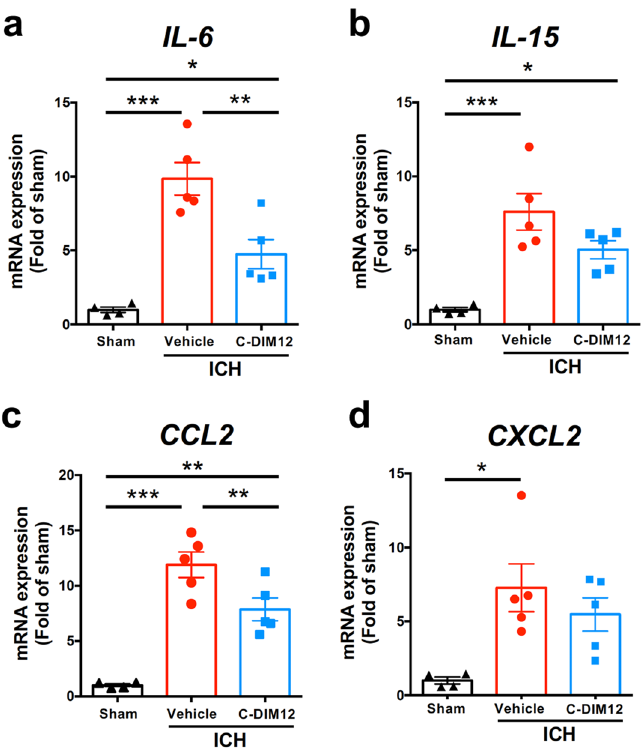
Figure 3. Effect of C-DIM12 on gene expression of pro-inflammatory cytokines and chemokines after ICH. C-DIM12 (50 mg/kg) or vehicle was orally administered at 3 h after ICH induction. Expression levels of IL-6 ( a ), IL-15 ( b ), CCL2 ( c ) and CXCL2 ( d ) mRNAs were quantified at 6 h after ICH. Number of mice examined was 4 in sham group, 5 in ICH + vehicle group, and 5 in ICH + C-DIM12 group, respectively. * P < 0.05, ** P < 0.01, *** P < 0.001 (ANOVA results: for a , F 2,11 = 22.26, P < 0.001; for b , F 2,11 = 14.07, P < 0.001; for c , F 2,11 = 30.44, P < 0.001; for d , F 2,11 = 6.360, P =